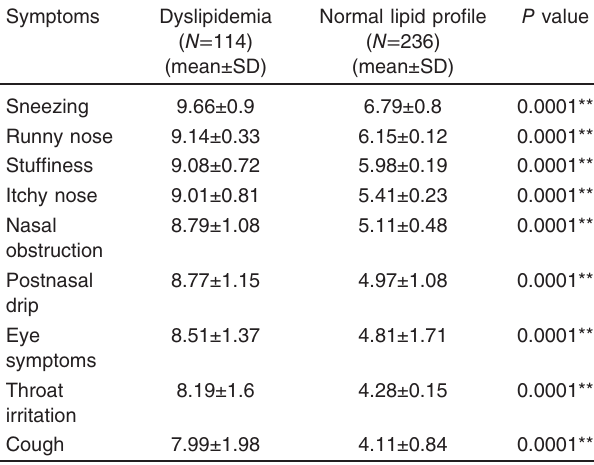
Table 2 Mean degree of different allergic nasal and extranasal symptoms in both groups Symptoms